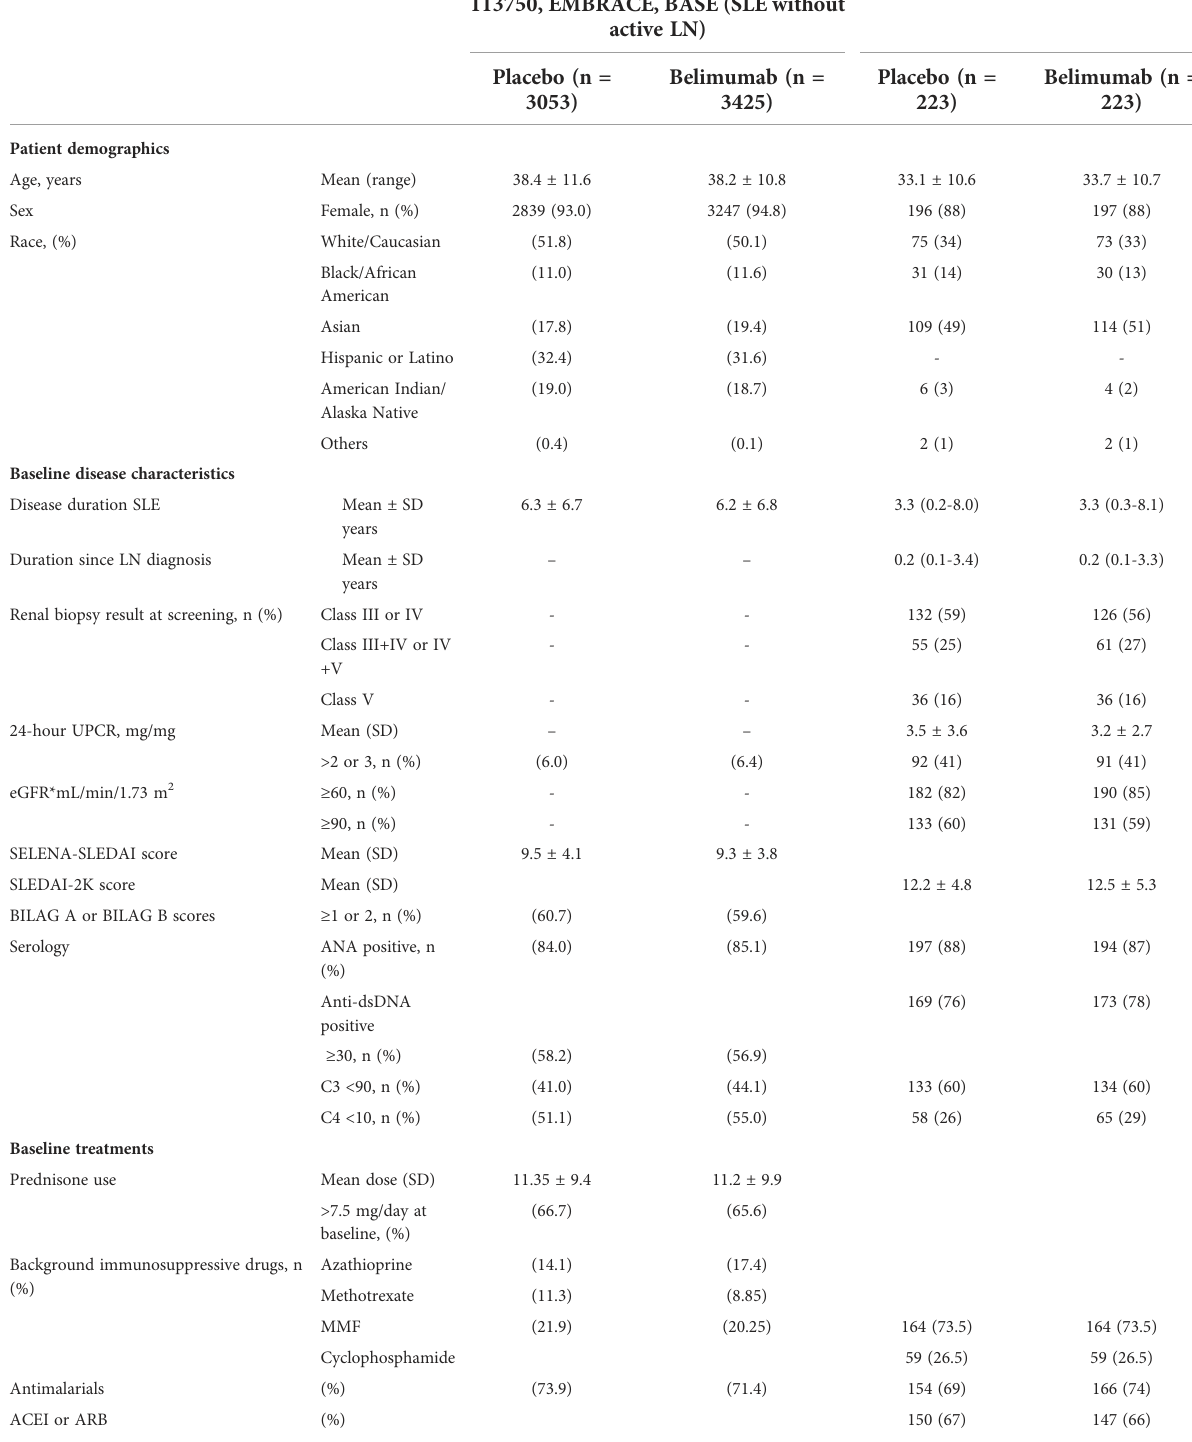
TABLE 2 Patient demographics and baseline/disease characteristics from the LBSL02, BLISS-52, BLISS-76 and BLISS-LN clinical